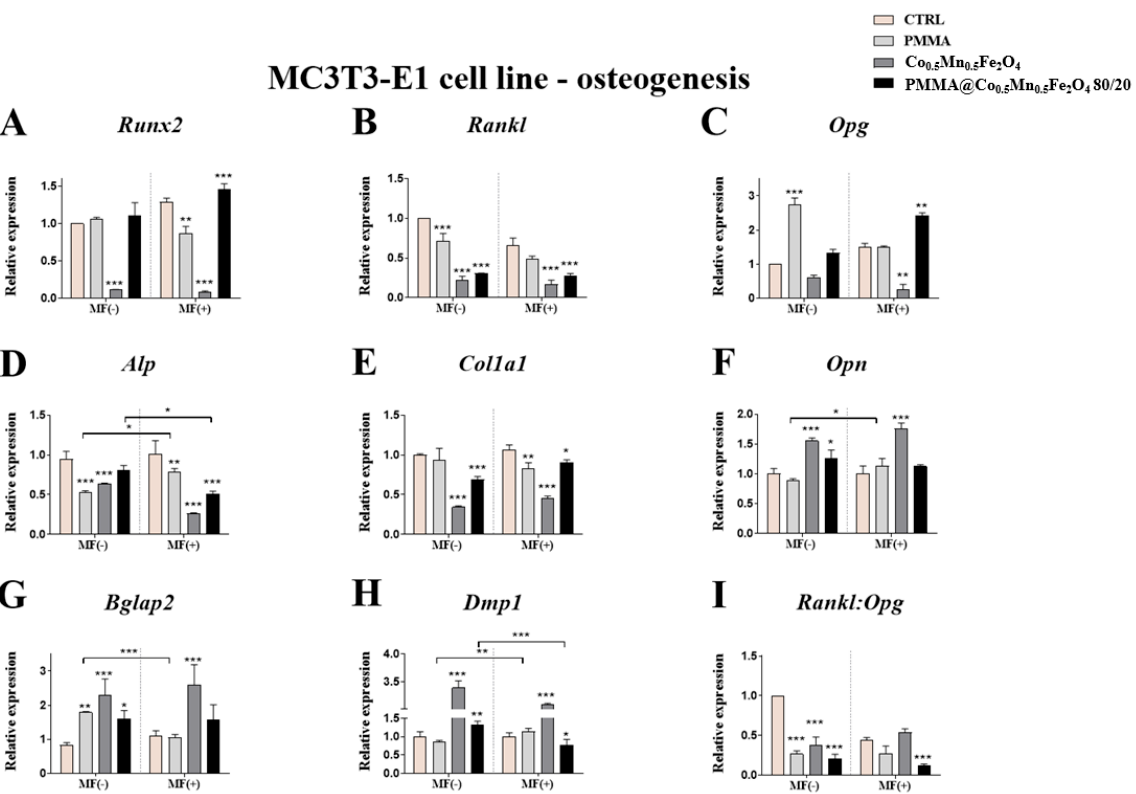
Figure 7. The impact of PMMA and its modification on the expression of genes related to osteogenesis: Runx2 ( A ), Rankl ( B ), Opg ( C ), Alp ( D ), Col1A1 ( E ), Opn ( F ), Bglap2 ( G ), Dmp1 ( H ), Rankl:Opg ( I ) in the magnetic field condition towards mouse pre-osteoblasts (MC3T3-E1 cell line).Statistical differences are indicated by * p < 0.005; ** p < 0.001 and *** p < 0.0001.